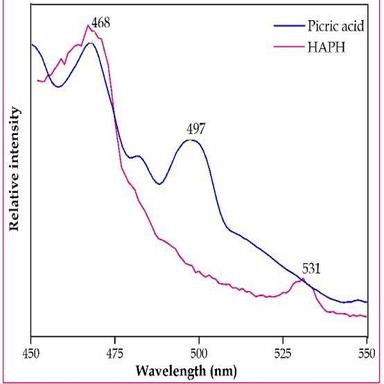
V-Vis spectrum of HAPH Fig. 9 Photoluminescence emission spectra